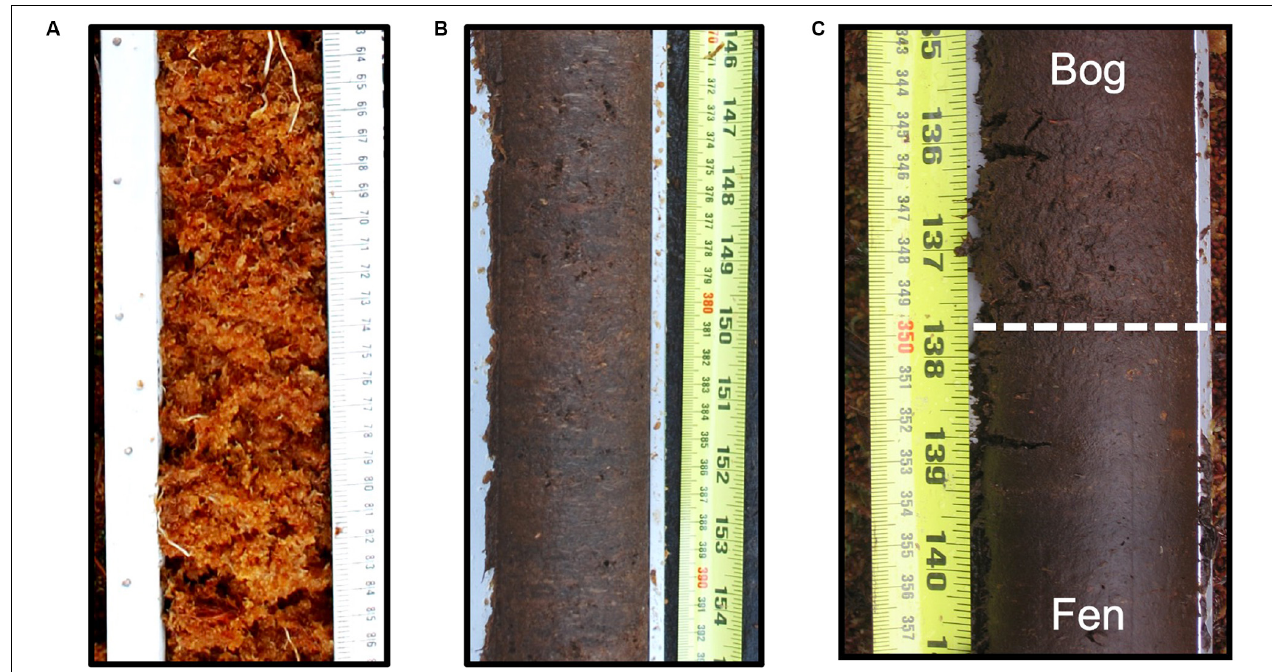
FIGURE 2 | Peat stratigraphic characteristics. (A) Sphagnum peat, poorly decomposed (core PAT10-HB). (B) Herbaceous peat, highly decomposed (core PAT10-CN). (C) Fen-bog transition along a peat core (site